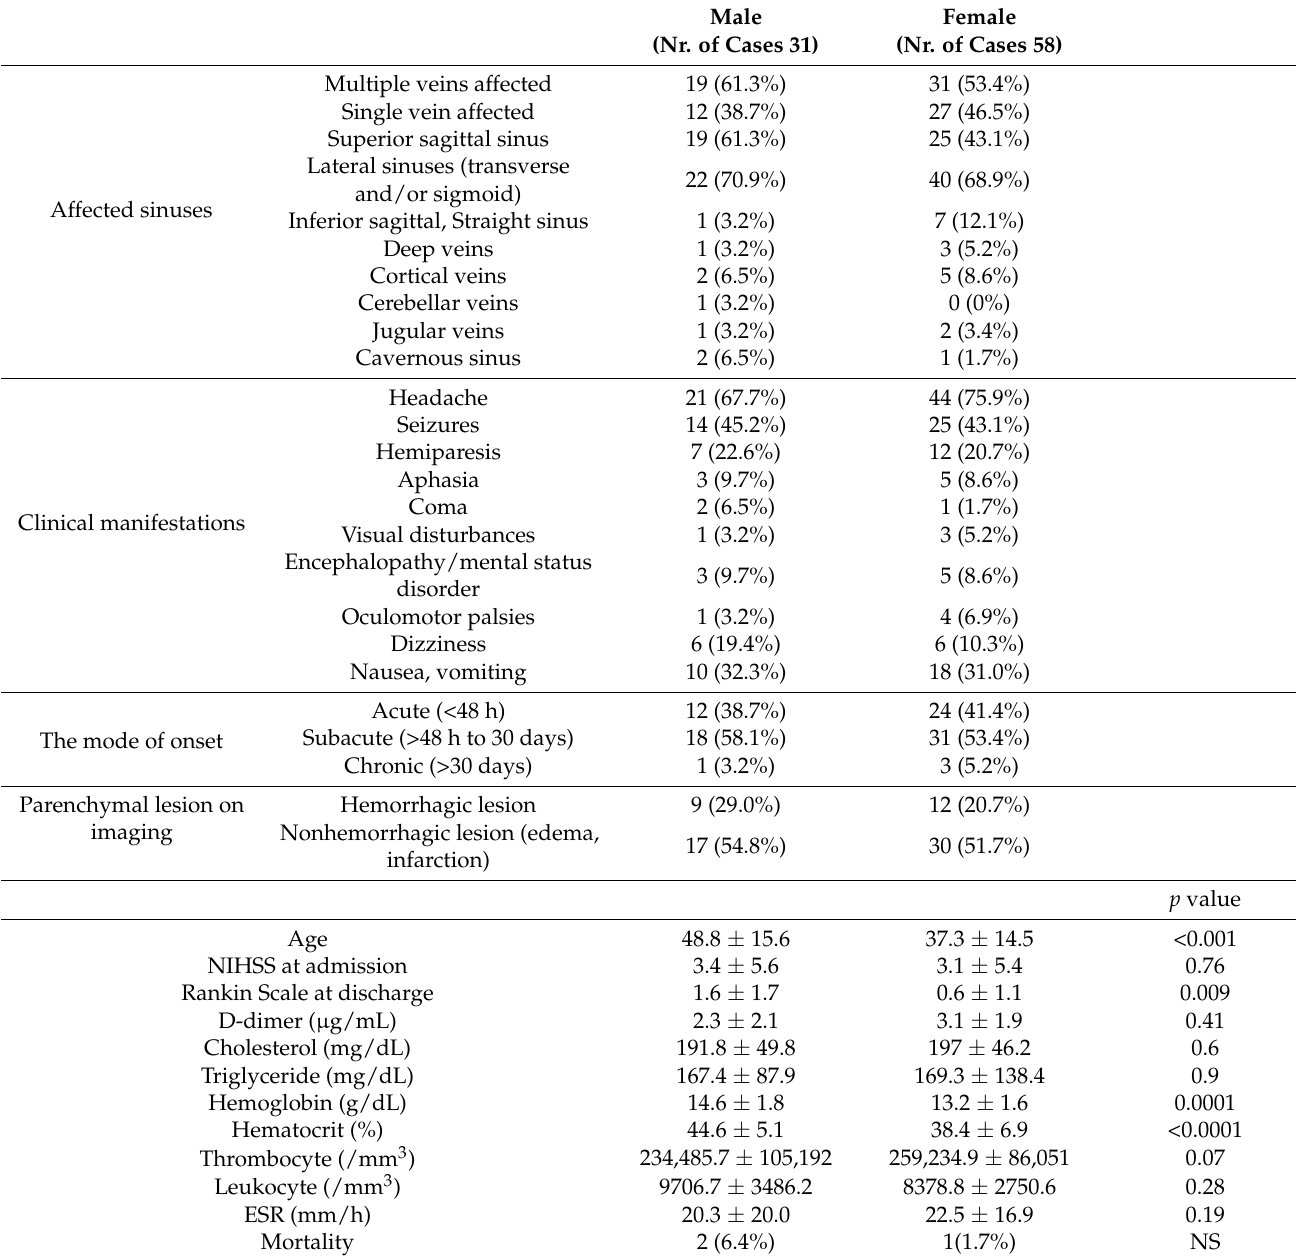
Table 2. The main clinical and paraclinical characteristics in male and female